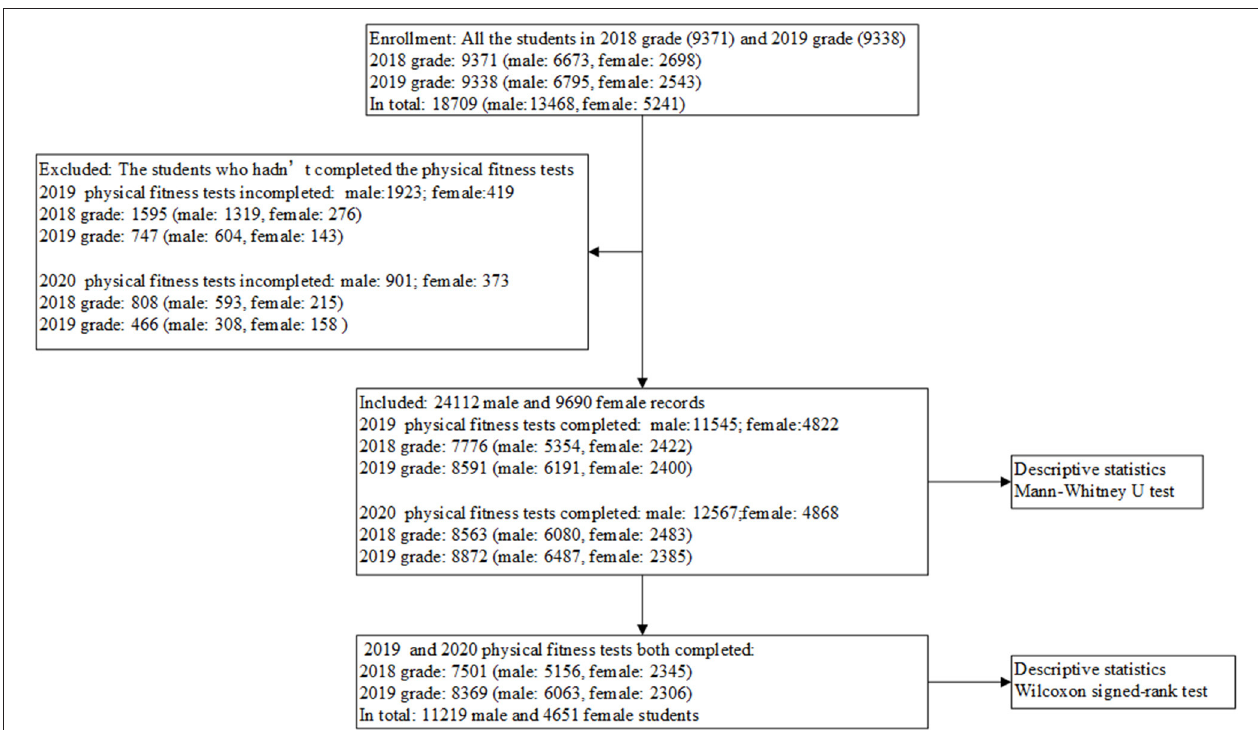
FIGURE 1 | Flow chart of this